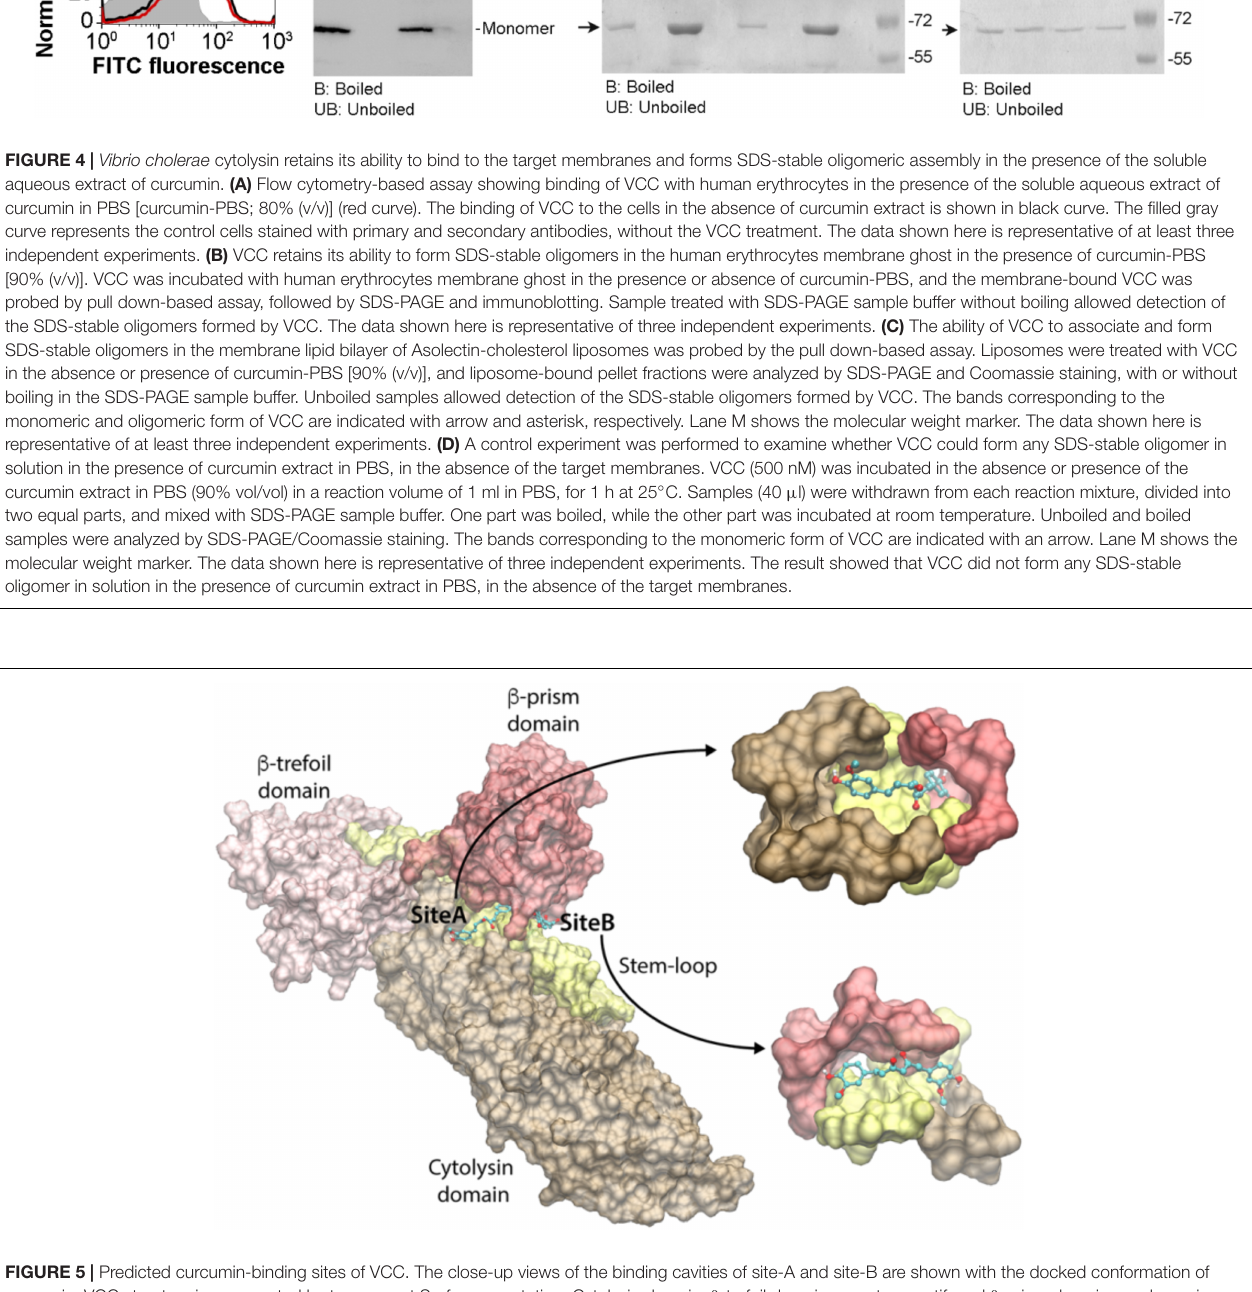
Frontiers in Microbiology |